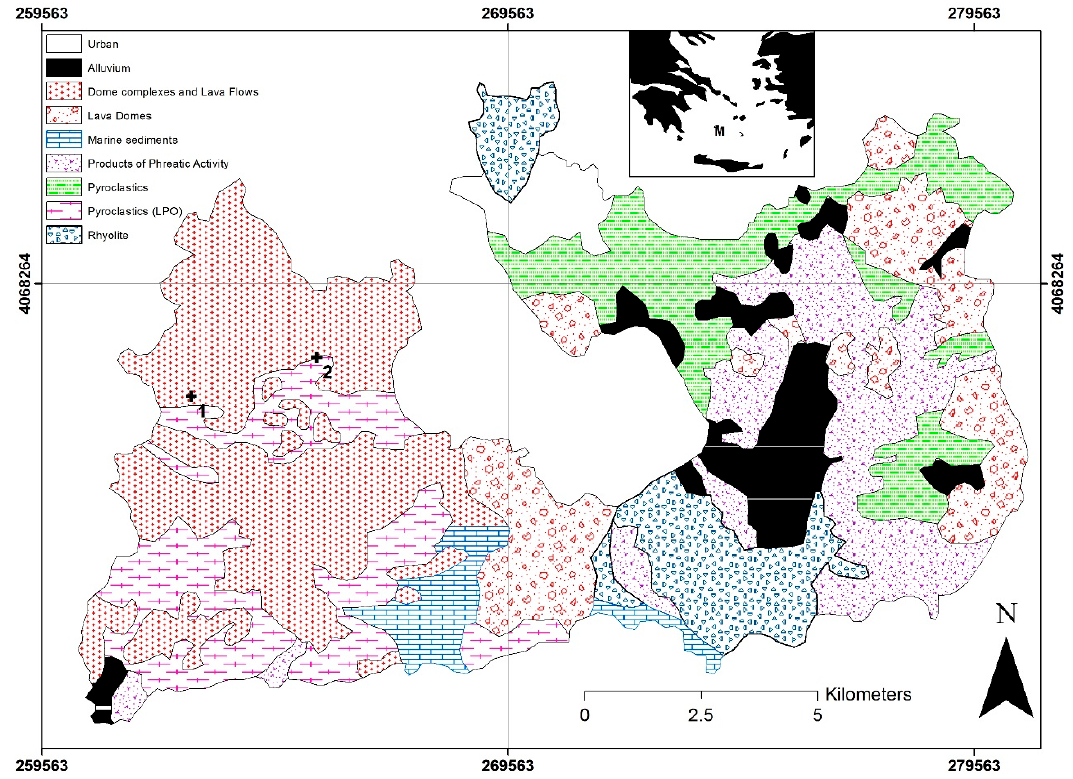
Figure 1. Geological map of Milos: 1—Triades-Galana; 2—Kondaros and inset map showing geographical location M (Modified from [35]).